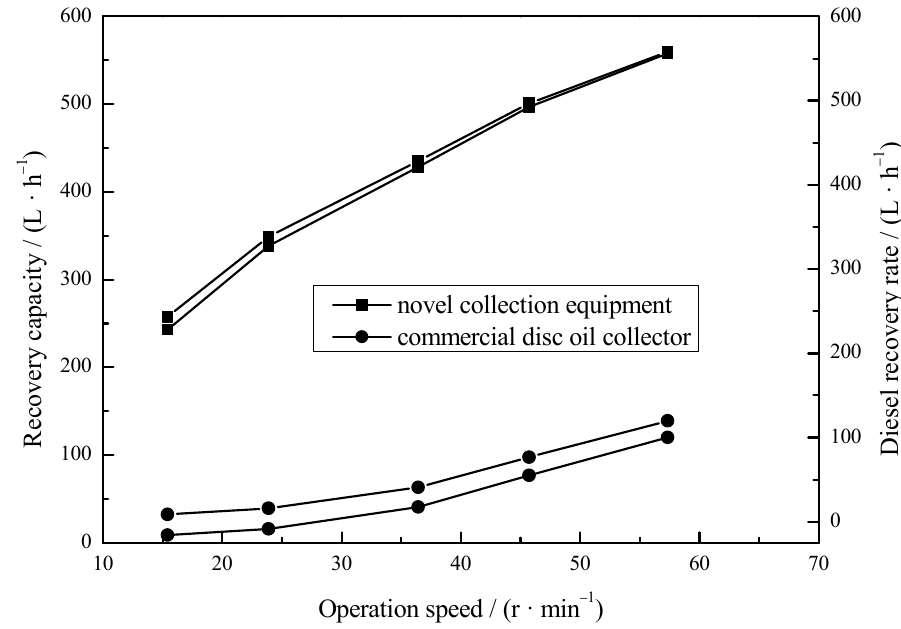
Figure 7. The maximum possible recovery capacity of the collection equipment.